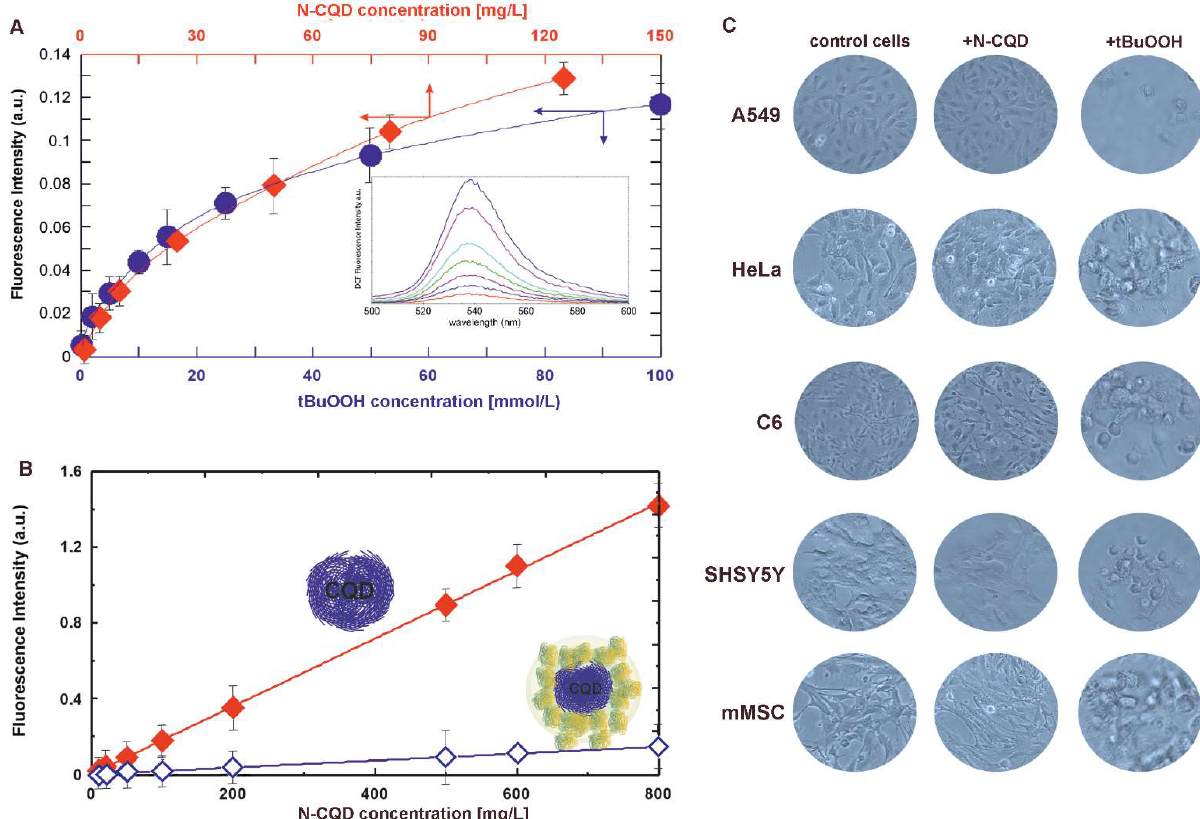
Figure 1. Oxidative properties of N-CQD and tBuOOH—( A ) fluorescence of dichlorofluorescein (DCF) reflects the amount of ROS produced in the presence of N-CQD (red) and tBuOOH (blue); inset—fluorescence spectra of DCF, ( B ) oxidative properties of N-CQD before (filled diamonds) and after (empty diamonds) albumin coating, ( C ) microscopic images of cells from different cell lines cultured with N-CQDs (20 µ g/mL in culture medium) and tBuOOH (10 mM) indicate different oxidative toxicity of both